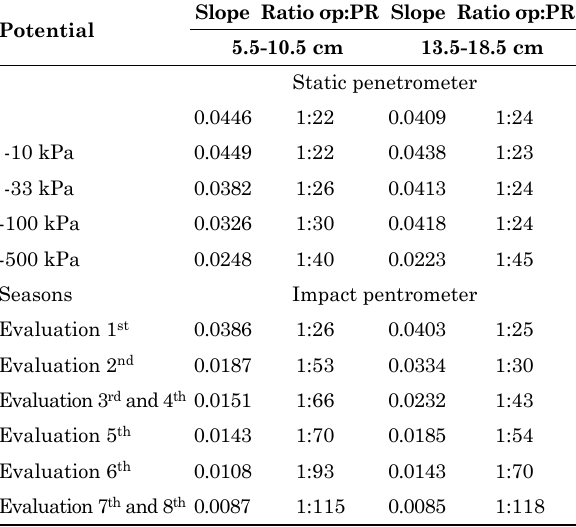
table 2. angular coefficients of the first degree equation (1) of the correlation between preconsolidation pressure (σp) and penetration resistance (pr), as related to the variation in soil water content due to different water potentials in the soil (static penetrometer) or to the number of days after irrigation (impact penetrometer)